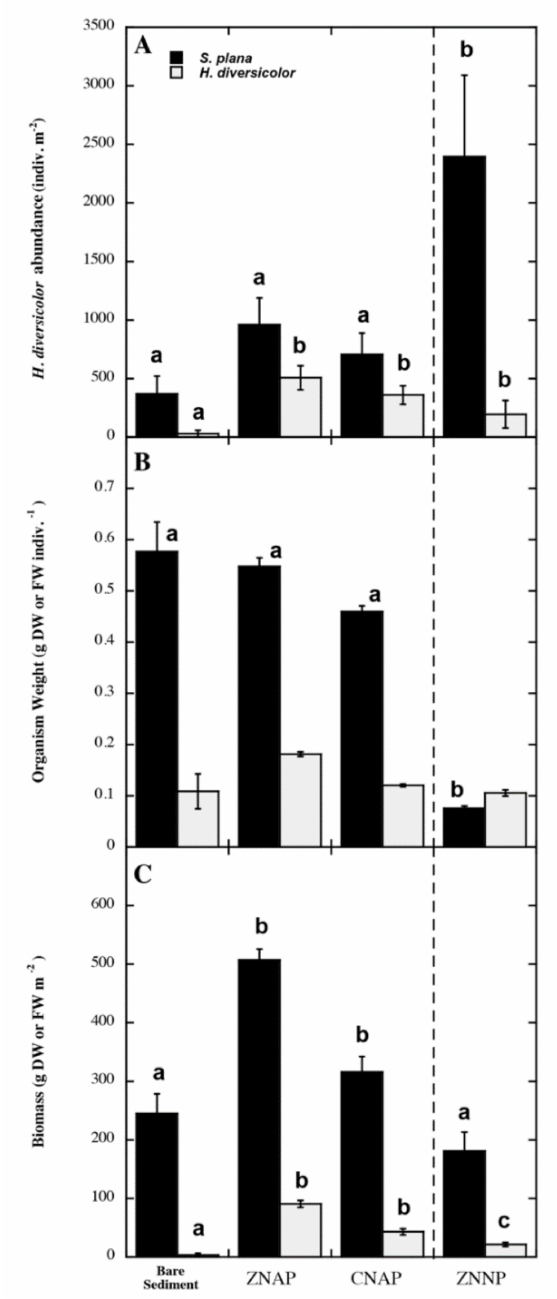
Figure 5. Density ( A ), organism individual weight ( B ), and total biomass ( C ) of the two main species recorded (>85%; Scrobicularia plana and Hediste diversicolor ) in the collected samples from the different habitats: bare sediment-BS; artificial patches of Zostera noltei -ZNAP, artificial patches of Cymodocea nodosa -CNAP, and natural patches of Zostera noltei -ZNNP. The weight of S. plana included the shell and the soft tissues and is given in dry weight, while H. diversicolor is expressed as fresh weight. The inset letters indicate significant differences among treatments using the Tuckey test. Data are represented as mean ±